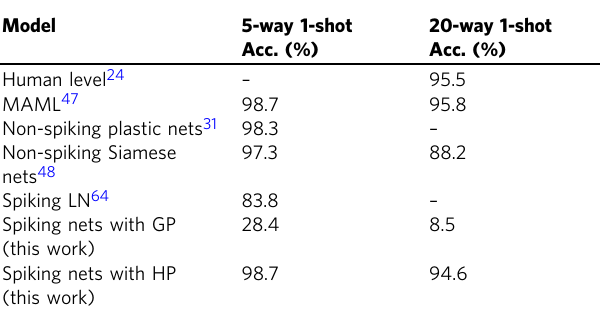
Table 2 Comparison of the state-of-art results on Omniglot